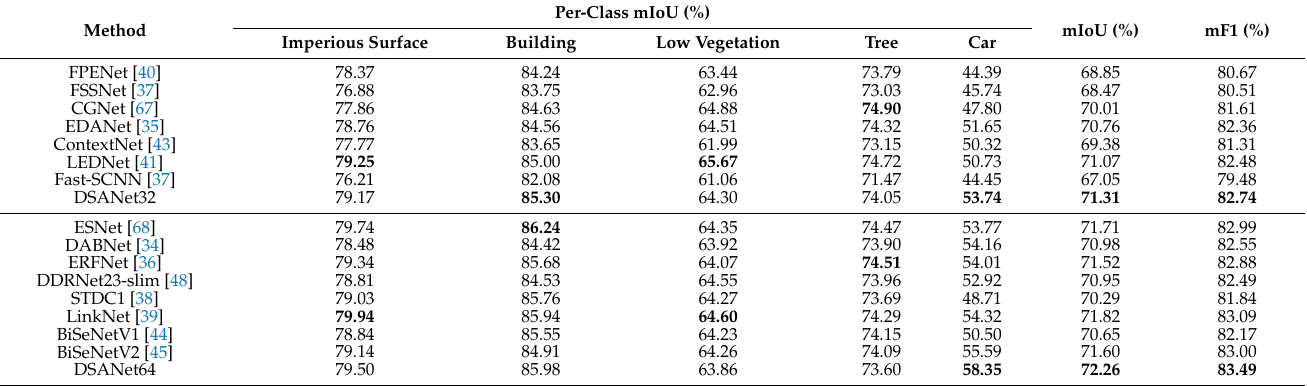
Table 9. Comparison of DSANet with the State-of-the-Art Models on the Vaihingen